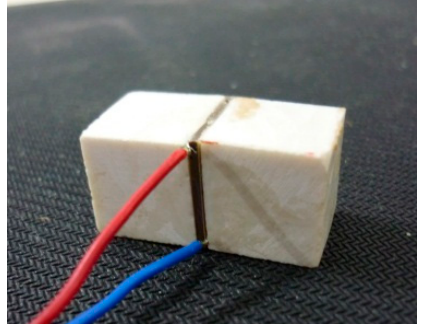
Figure 13. Fabricated transducer.